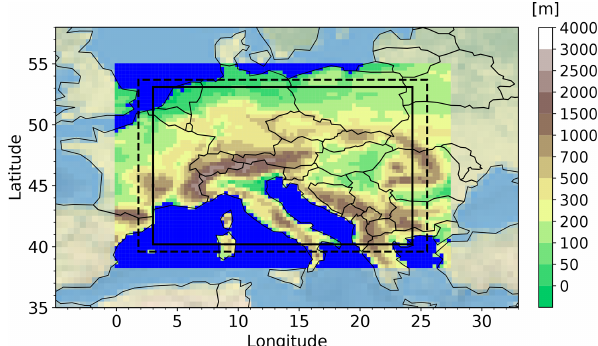
Figure 1. Topographic height of the surface from the ERA5 reanal- ysis dataset remapped onto a regular, spherical grid with (cid:49)x = 0.3 ◦ . The grid boxes of the target domain are highlighted by opaque colours. The dashed and solid lines bound the subdomains in the sensitivity study. The domains comprise 92 × 56, 80 × 48 and 72 × 44 grid points in the zonal and meridional direction, respec-